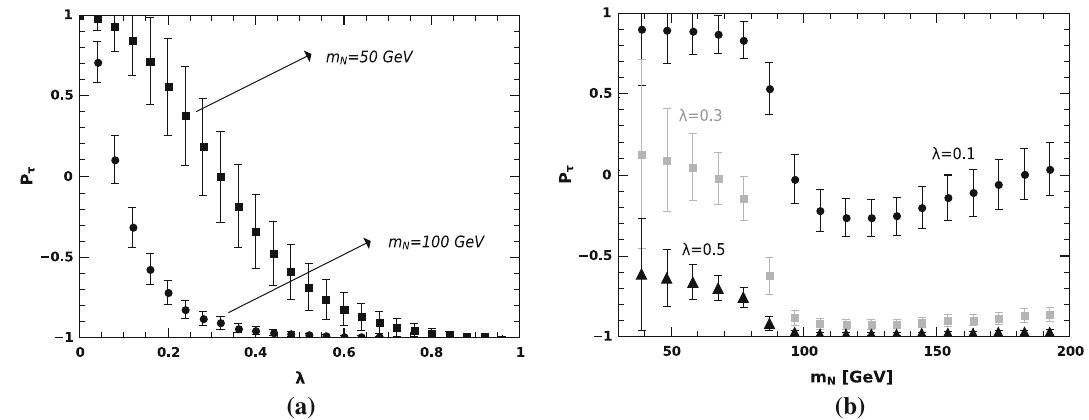
Fig. 8 Final anti-tau polarization P τ as defined in Eq. (20) a as a function of λ for different m N values and b as a function of m N for different λ